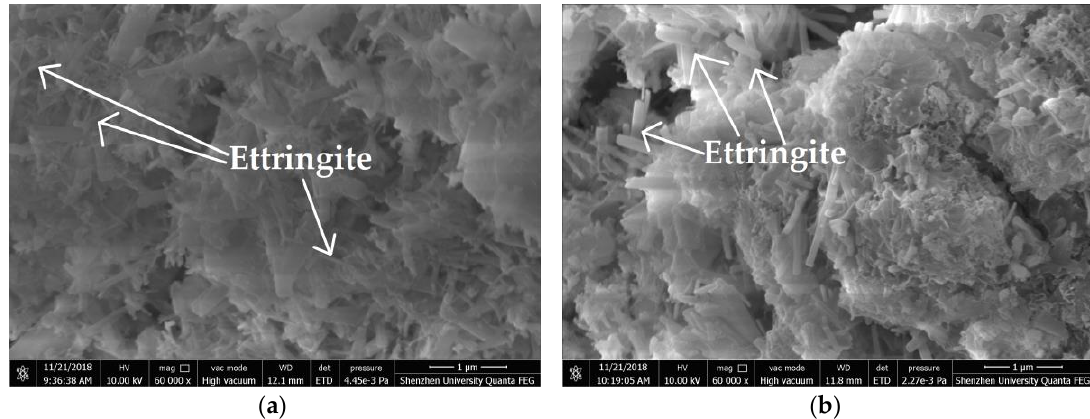
Figure 12. SEM images of hardened paste: ( a ) control; ( b ) with 1.0% HPMC.